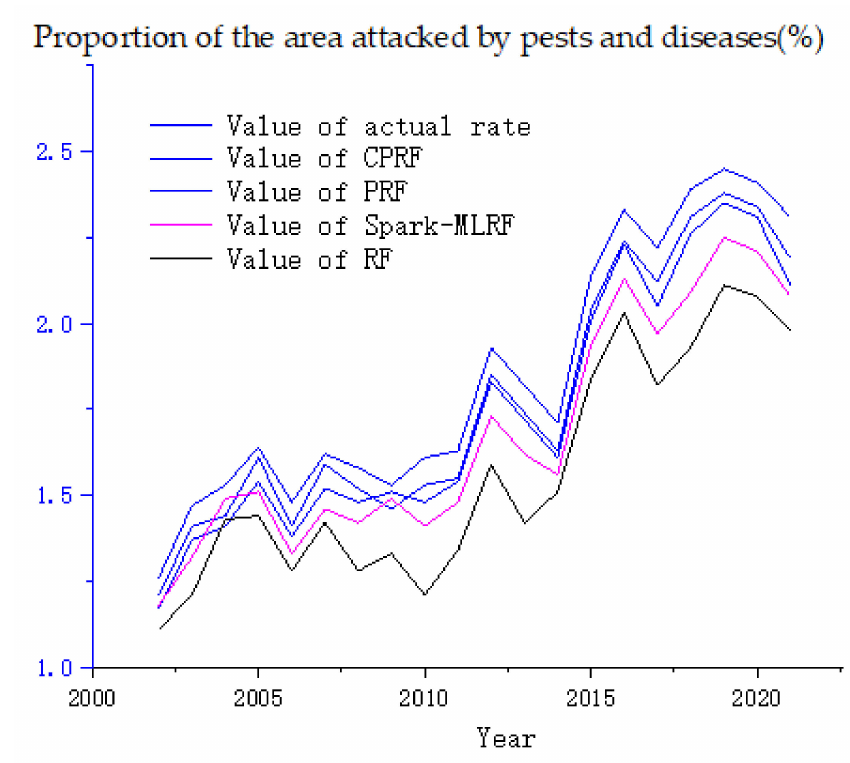
Figure 6. Comparison of four algorithms by using the proportion of affected